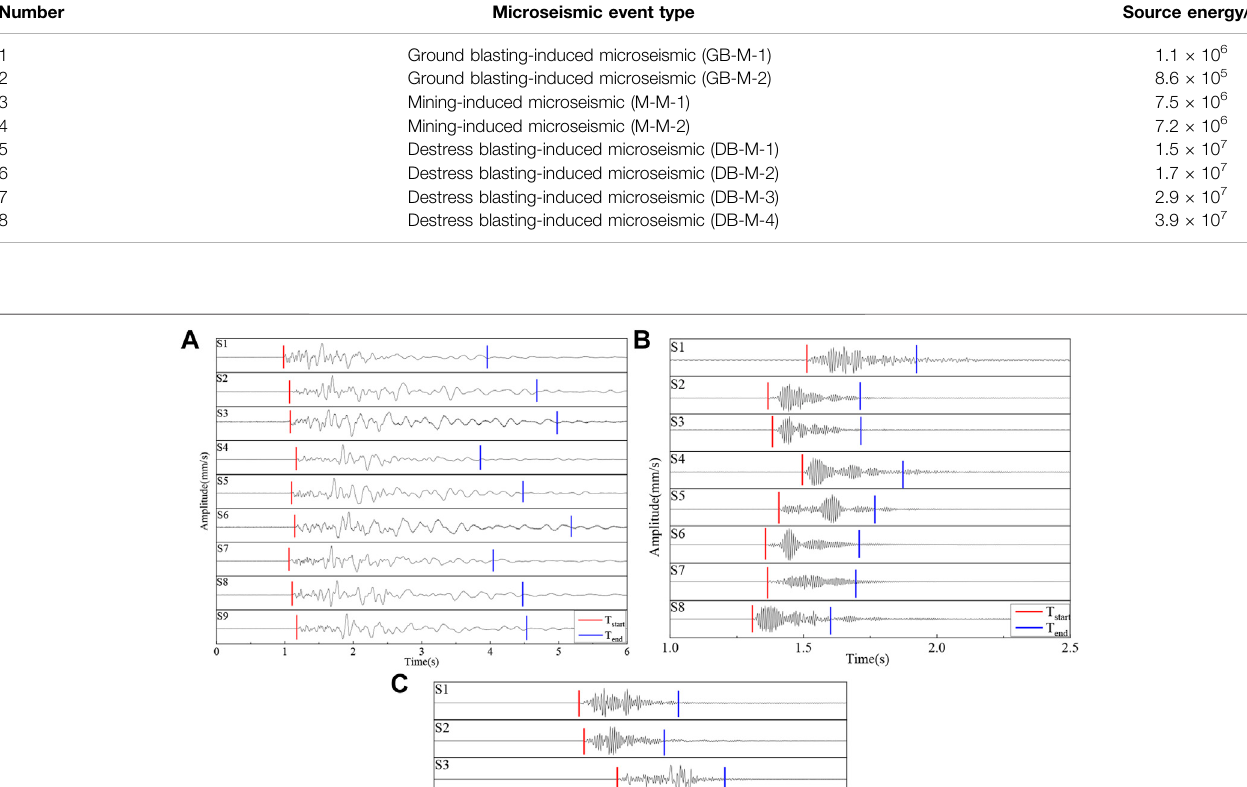
Frontiers in Earth Science |